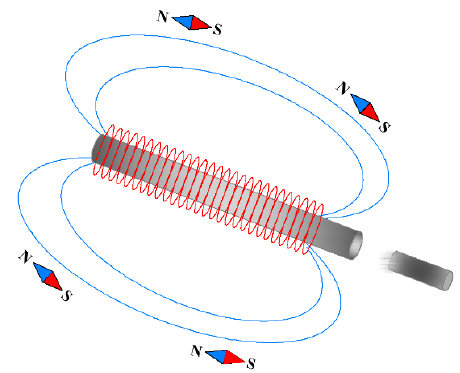
Figure 4. Schematic of the electromagnetic gun.